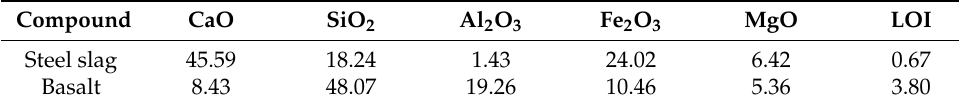
Table 5. Chemical composition of steel slag and basalt (%).